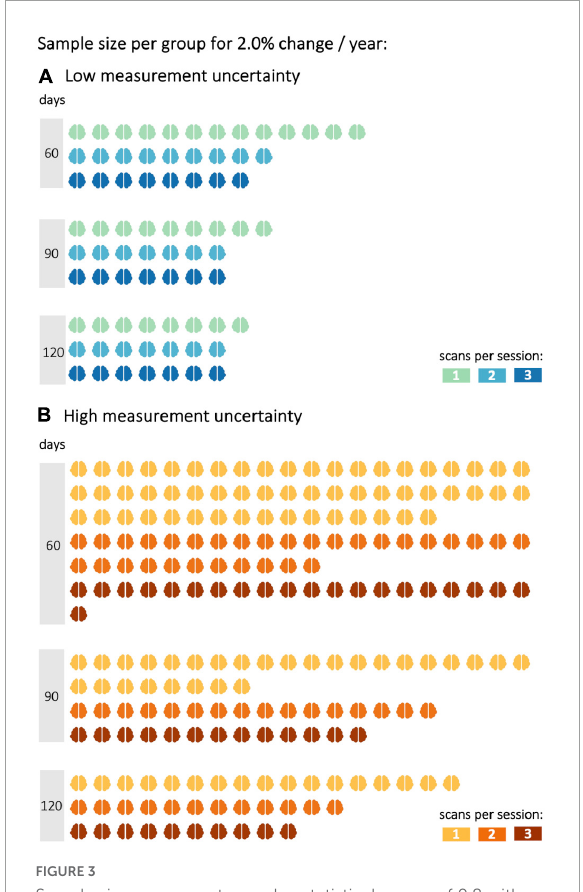
FIGURE3 Sample size per group to reach a statistical power of 0.8 with different decrease rates in fractional anisotropy (FA). FA values were either subject to (A) low or (B) high measurement uncertainty. Statistical power calculations were performed for 60, 90, and 120 days between baseline and follow-up sessions and one to three scans per